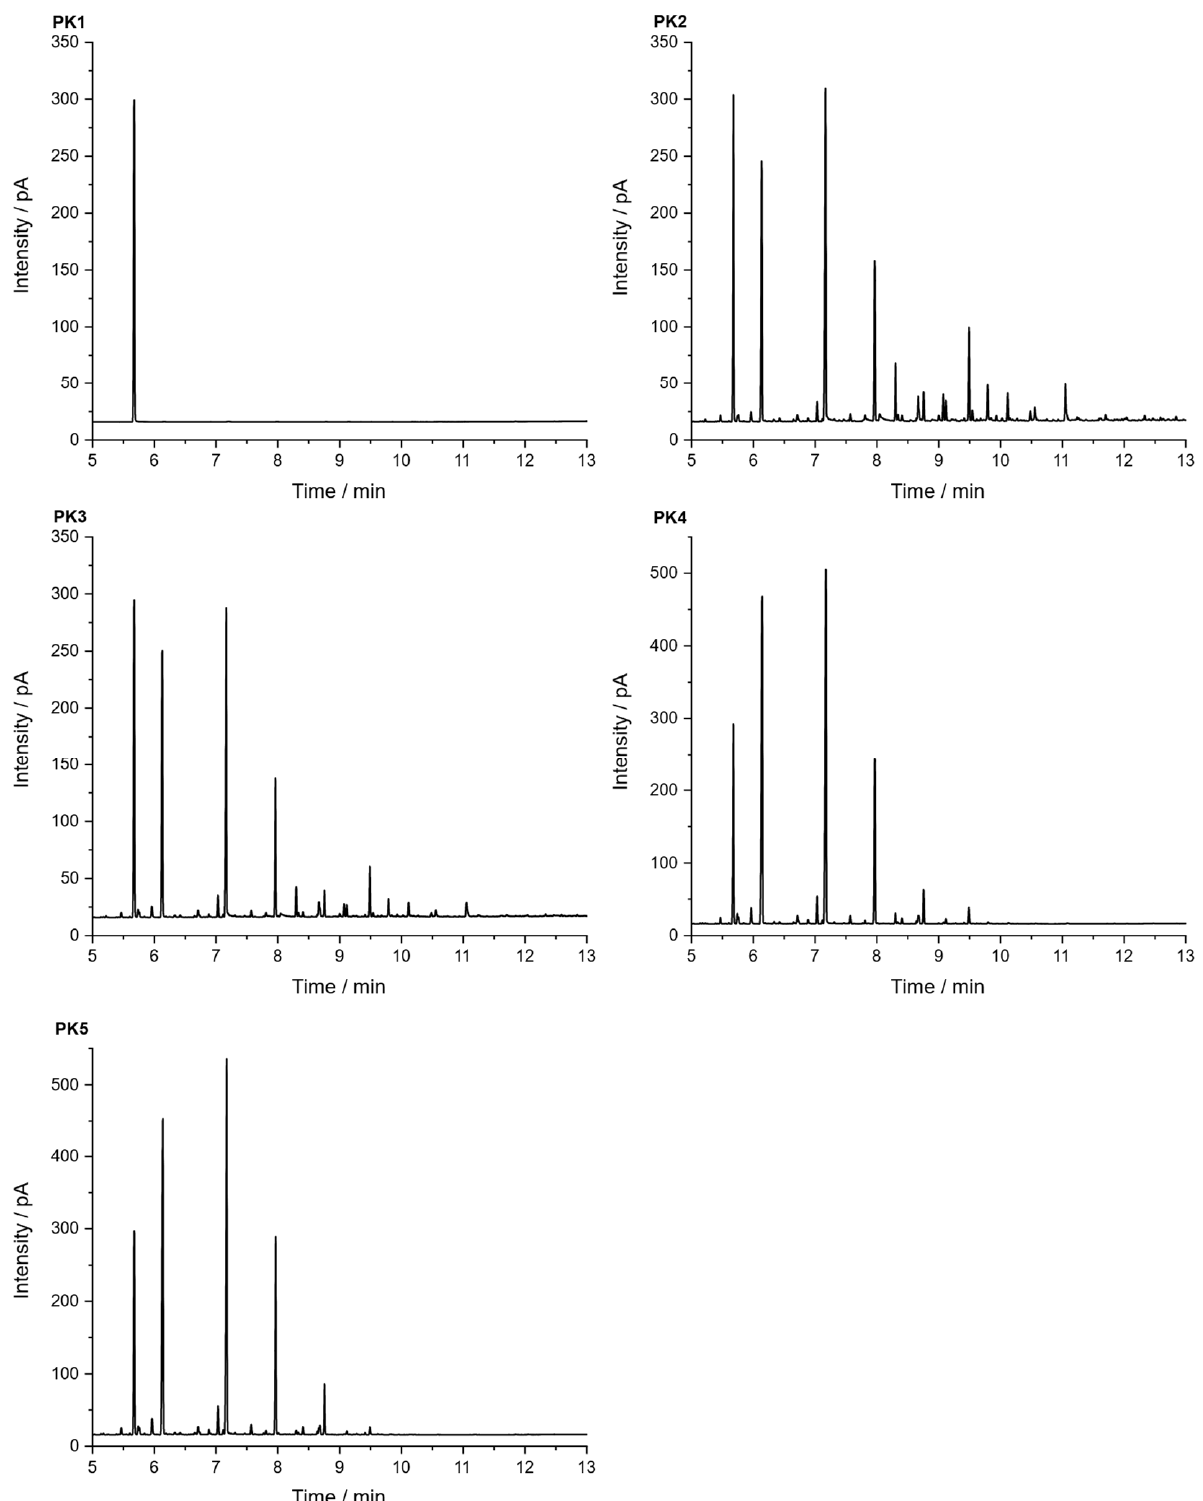
Figure A2. GC-FID chromatograms of the temperature series condensates of the pine kraft lignin.